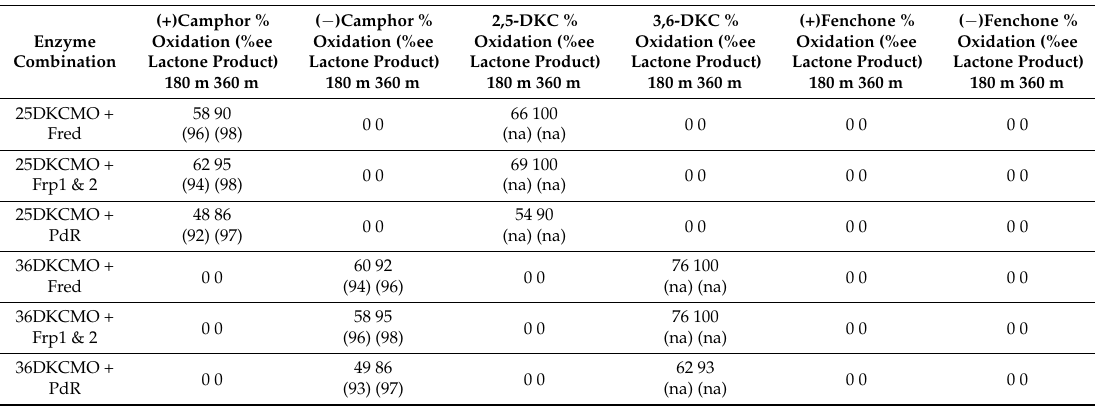
Table 1. Biotransformations of mono- and diketone chiral substrates by various diketocamphane monooxygenase-flavin reductase